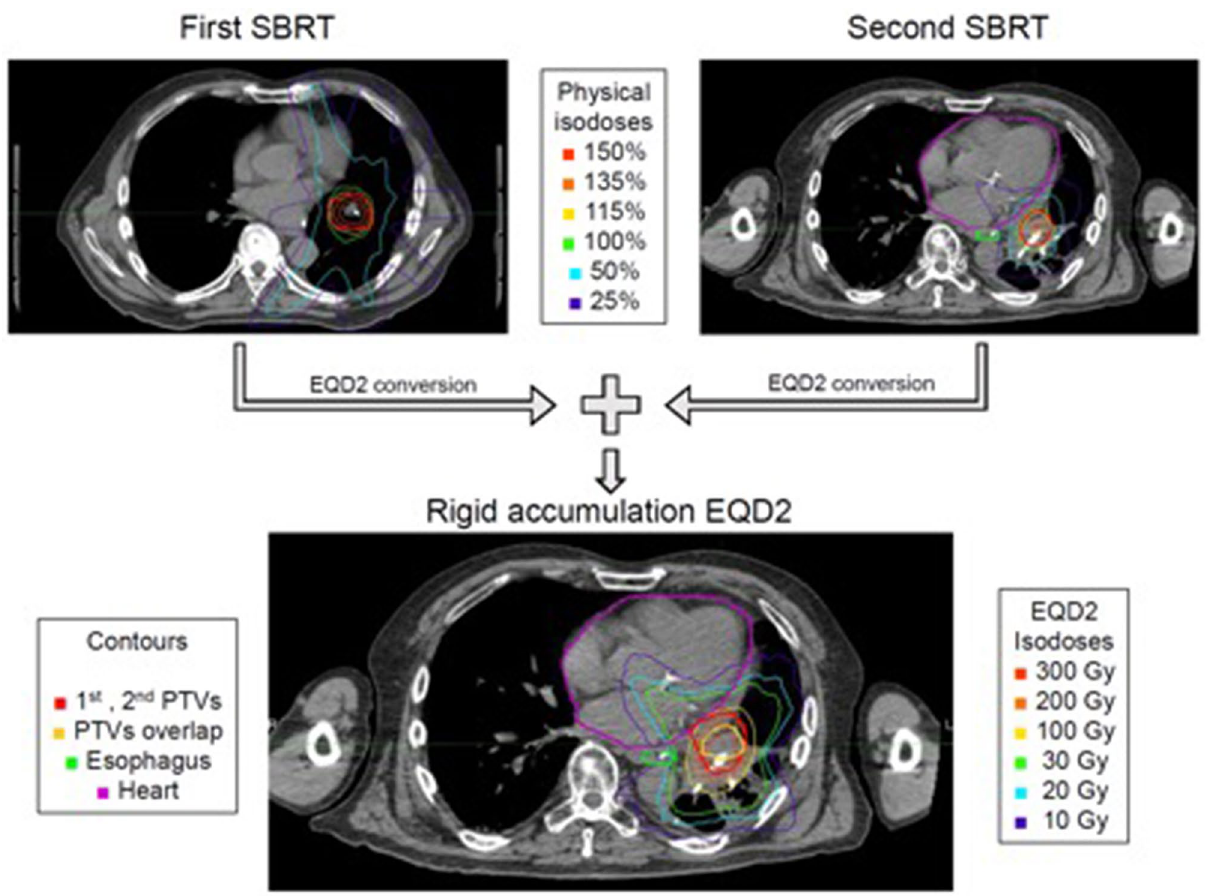
Figure 1. Exemplary case of the plan summation in MIM (version 6.9.2, MIM Software Inc., Cleveland, USA). The top row shows the first and second SBRT plans. The physical doses are normalized to 100% for the prescription to the PTV. Such doses are converted into EQD2 and rigidly accumulated onto the most recent CT. The result is shown at the